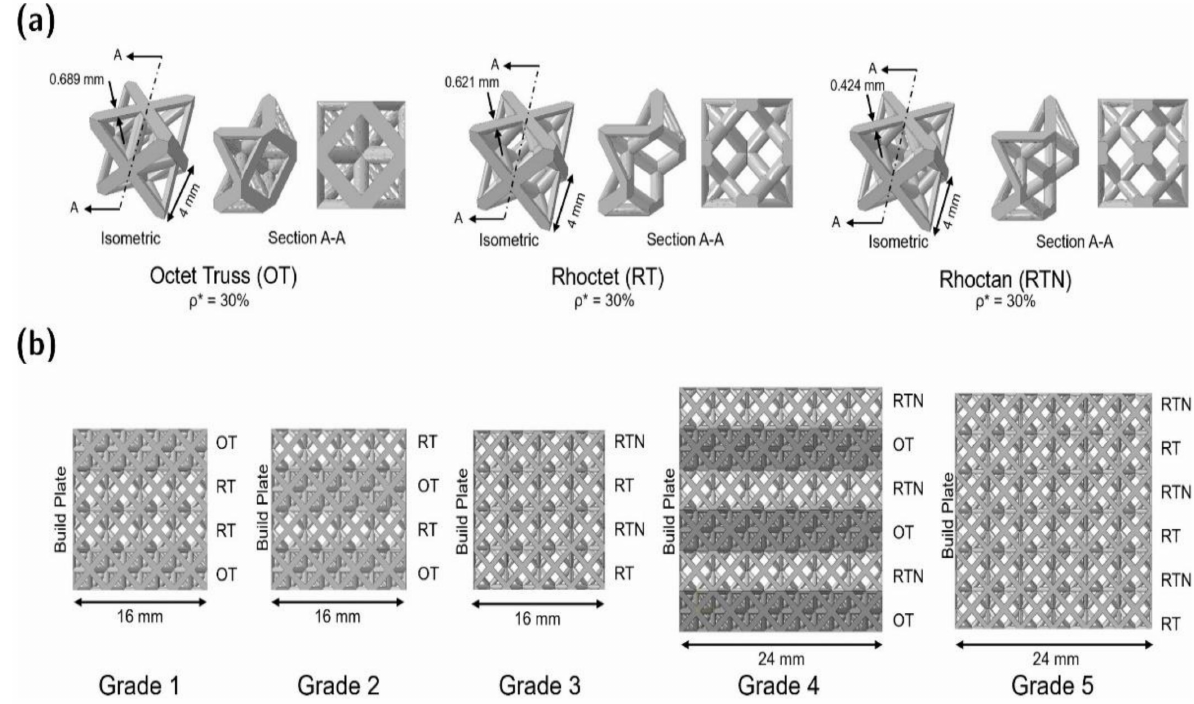
Figure 5. ( a ) shows the three unit cell topologies used in specimens in this study, OT, RT, RTN. Each of the three unit cell topologies has relative density ( ρ ∗ ) of 30% ( b ) shows the five hybrid lattice structure configurations examined in this study. The built plate of each specimen type is noted so that build orientation can be considered in this analysis. Reprinted with permission from ref. [59]. 2021,